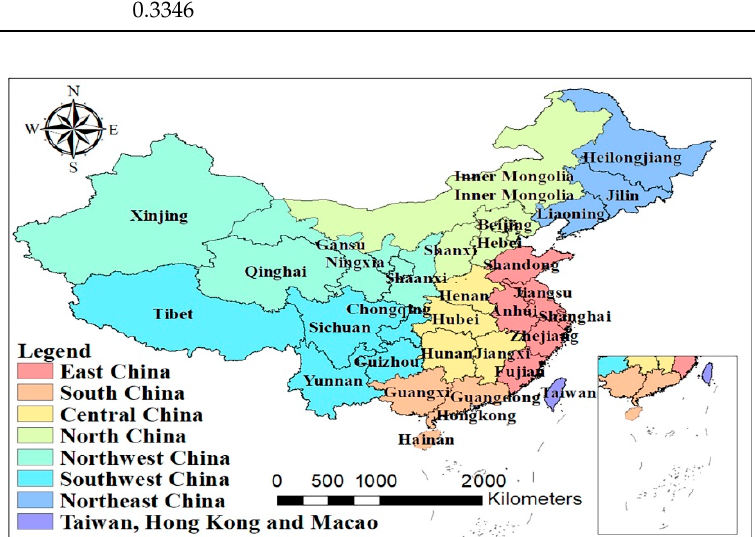
Figure 2. Specific administrative division of China.